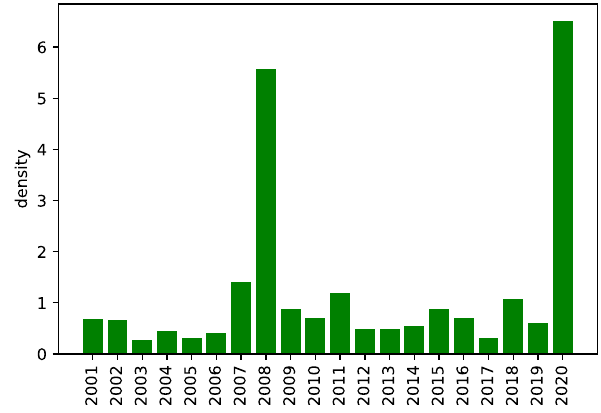
Figure 1: Evolution of arc